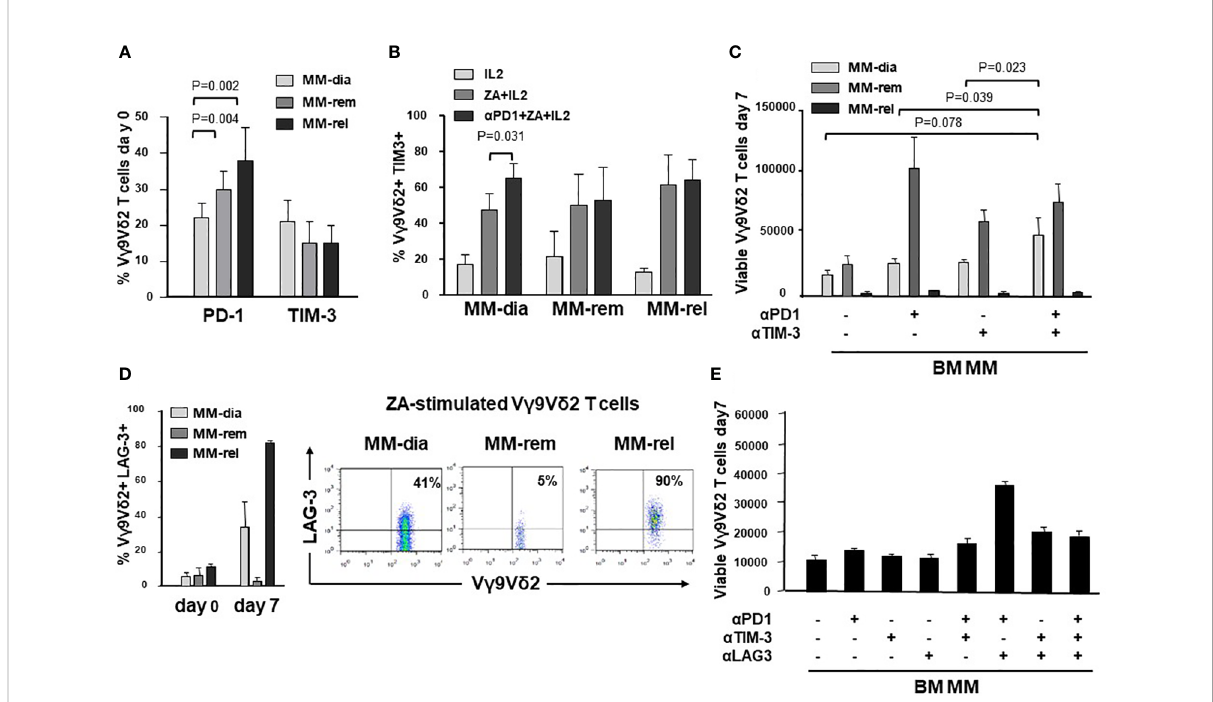
FIGURE 7 The ICP/ICP-L network is dynamically shaped by the disease status. (A) PD-1 and TIM-3 expression in resting BM V g 9V d 2 T cells from MM patients at different stages of disease (MM-dia, MM-rem and MM-rel). Bars represent the mean values ± SE from 7 (MM-rel) to 50 (MM-dia). (B) TIM-3 expression in BM MM V g 9V d 2 T cells after 7-day ZA stimulation in the presence or absence of a PD1. Bars represent the mean values ± SE from 3 (MM-rem) to 6 (MM-dia). (C) BM MM V g 9V d 2 T-cell proliferation in MM-dia, MM-rem and MM-rel after 7-day ZA stimulation in the presence of a PD1, a TIM-3, and the combination thereof. Bars represent the mean values ± SE from 4 (MM-rem) to 8 (MM-dia). (D) left: LAG-3 expression in resting (day 0) or ZA-stimulated BM V g 9V d 2 T cells from MM patients at different stages of disease (MM-dia, MM-rem and MM-rel). Bars represent the mean ± SE from 4 (MM-rel) to 5 (MM-dia) experiments; right: cyto fl uorimetric analyses of LAG-3 expression in ZA-stimulated V g 9V d 2 T cells from one representative MM-dia, MM-rem, and MM-rel. (E) BM MM V g 9V d 2 T-cell proliferation in MM-rel after 7-day ZA stimulation in the presence a PD1, a TIM-3, and a LAG-3 as single agents or in combination. Bars represent the mean ± SE of 3